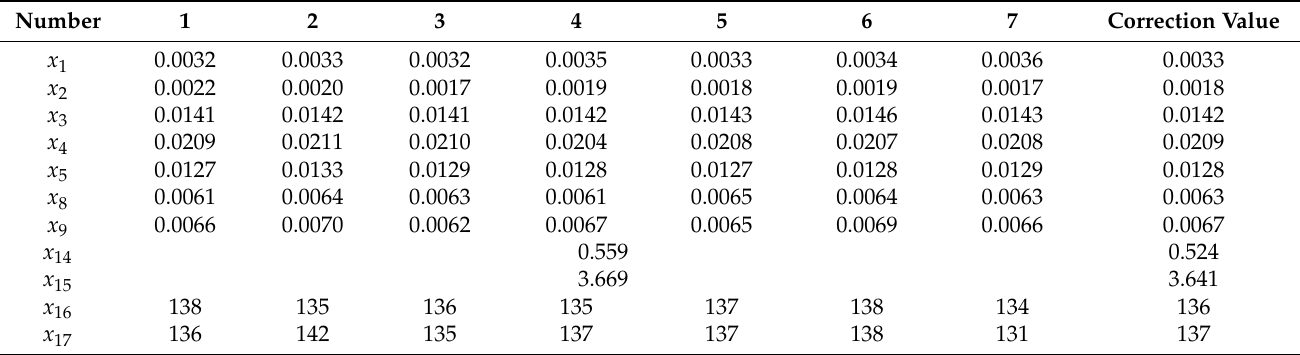
Table 5. Measurement data correction results.